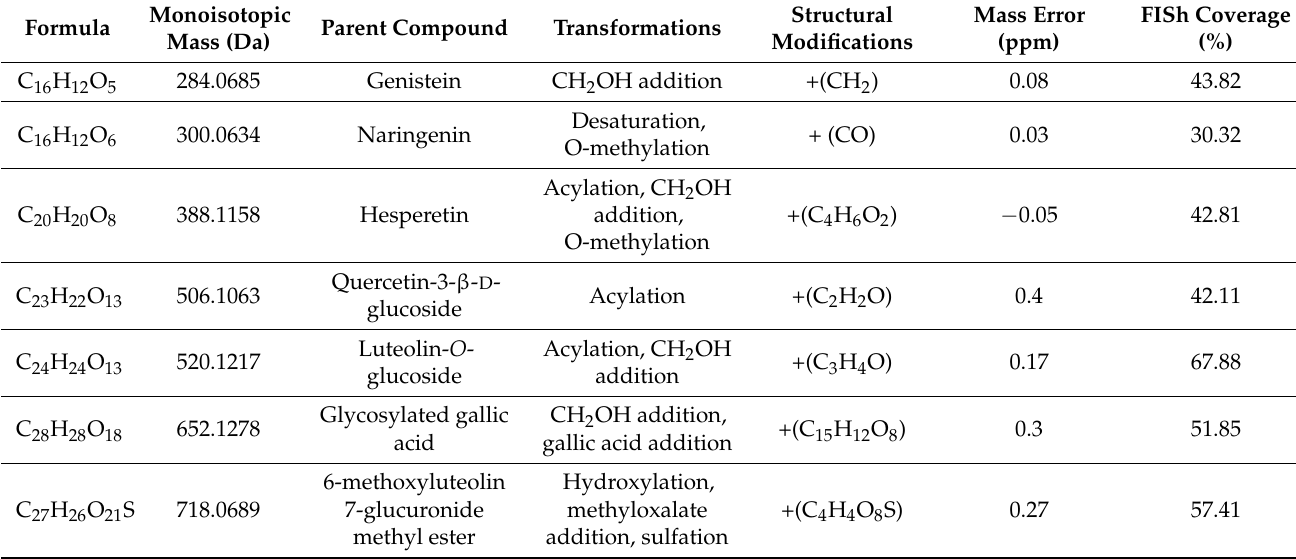
Table 3. Structural prediction of unknown flavonoids by means of a structural transformation database-driven data processing